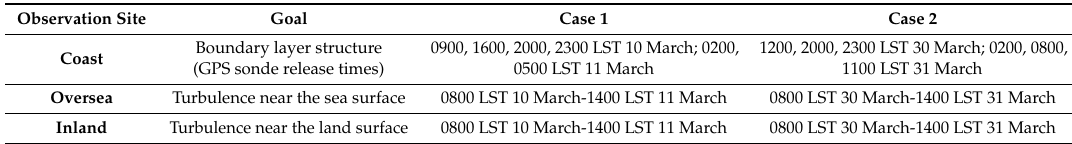
Table 3. Measurement goals and analysis periods (LST) at the three observation sites for both cases of sea